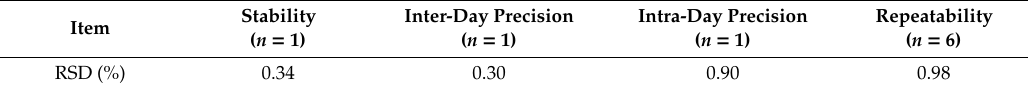
Table 3. Stability, precision, and repeatability of the Cy-3-glc quantification method.